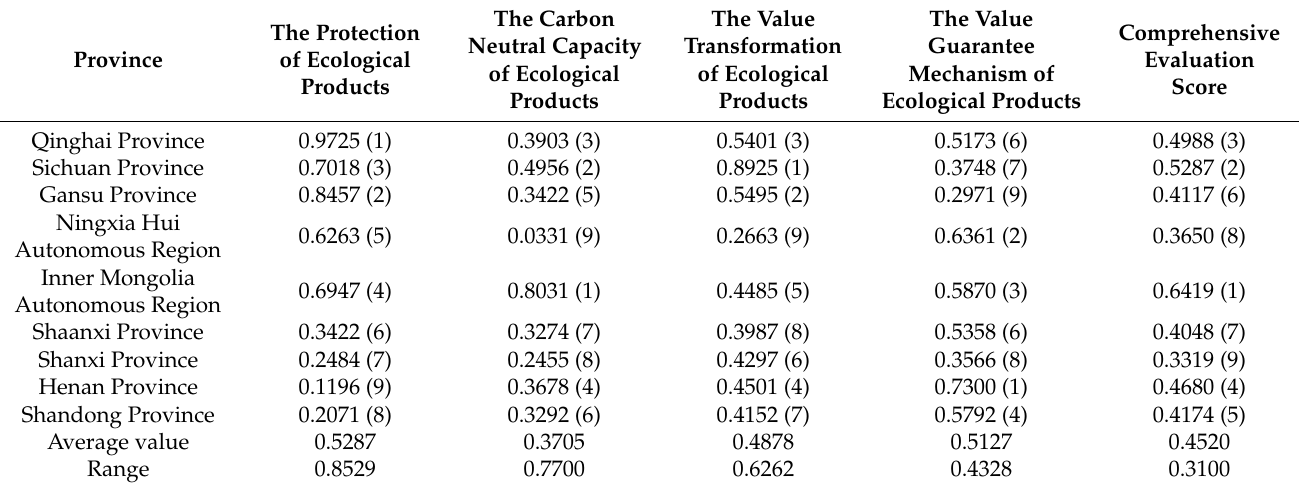
Table 7. The value evaluation score of ecological products in nine provinces of the Yellow River basin in 2020.